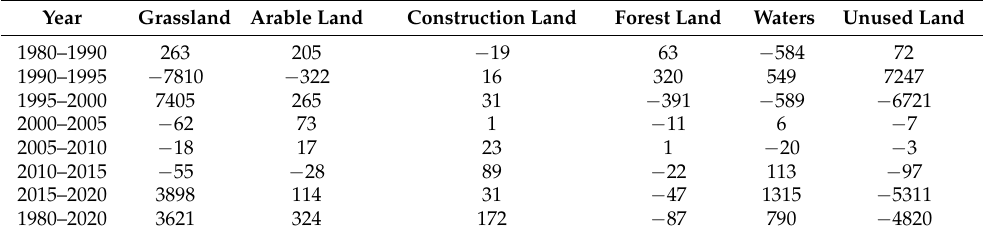
Table 9. The changes in the area of various land types in the Qilian Mountains from 1980 to 2020 (km 2